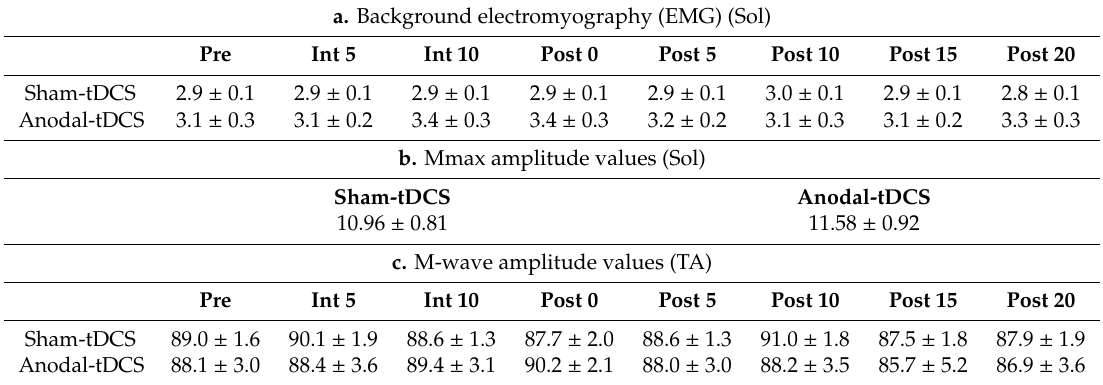
Table 1. The Sol muscle background EMG, Mmax amplitude values of the Sol muscle, and the M-wave amplitude values of the TA muscle.